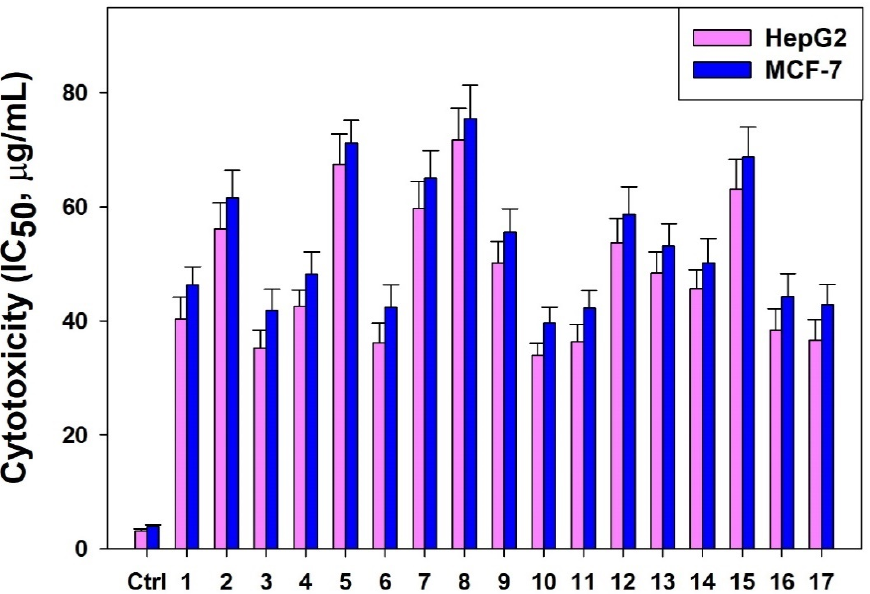
Figure 6. The estimated IC 50 values (µg/mL) of BBD-run TCME samples on HepG2 and MCF-7 cell lines. (ctrl: control).